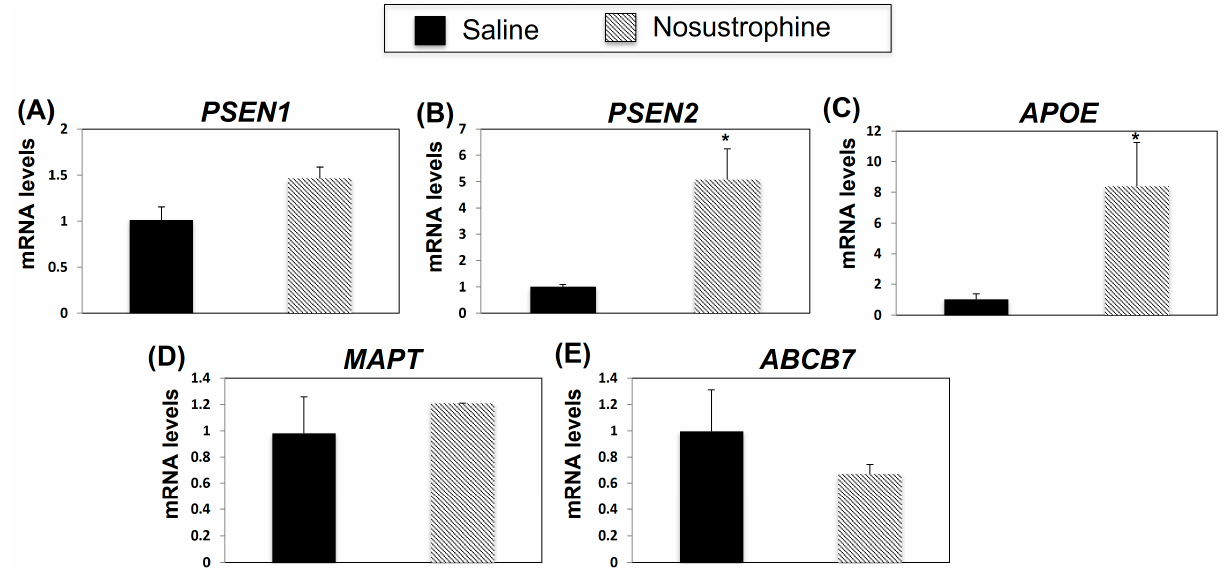
Figure 5. Nosustrophine regulates AD-related gene expression in 8–9 month-old trigenic AD mice. PSEN1 ( A ), PSEN2 ( B ), APOE ( C ), MAPT ( D ) and ABCB7 ( E ) mRNA levels were measured by qPCR in hippocampus from 3xTg-AD mice ( n = 4 animals per group). Results are expressed as fold induction versus saline-treated trigenic mice. Data are expressed as means ± S.E.M. * p < 0.05.